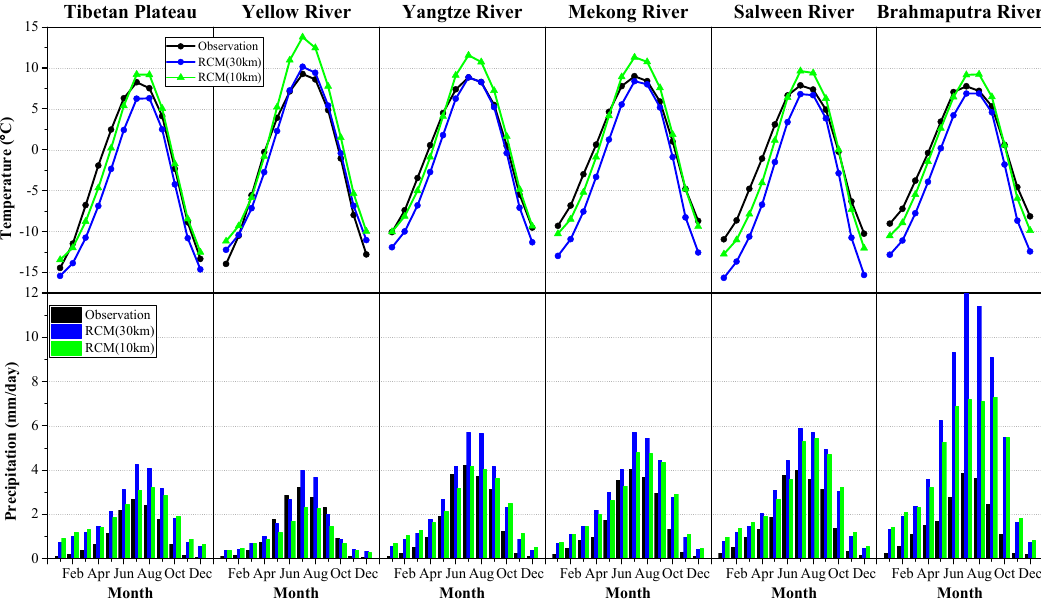
Figure 7. The comparison of observations with annual cycle of simulated monthly mean temperature and precipitation over TP and five river basins for the period 1980 − 2010.